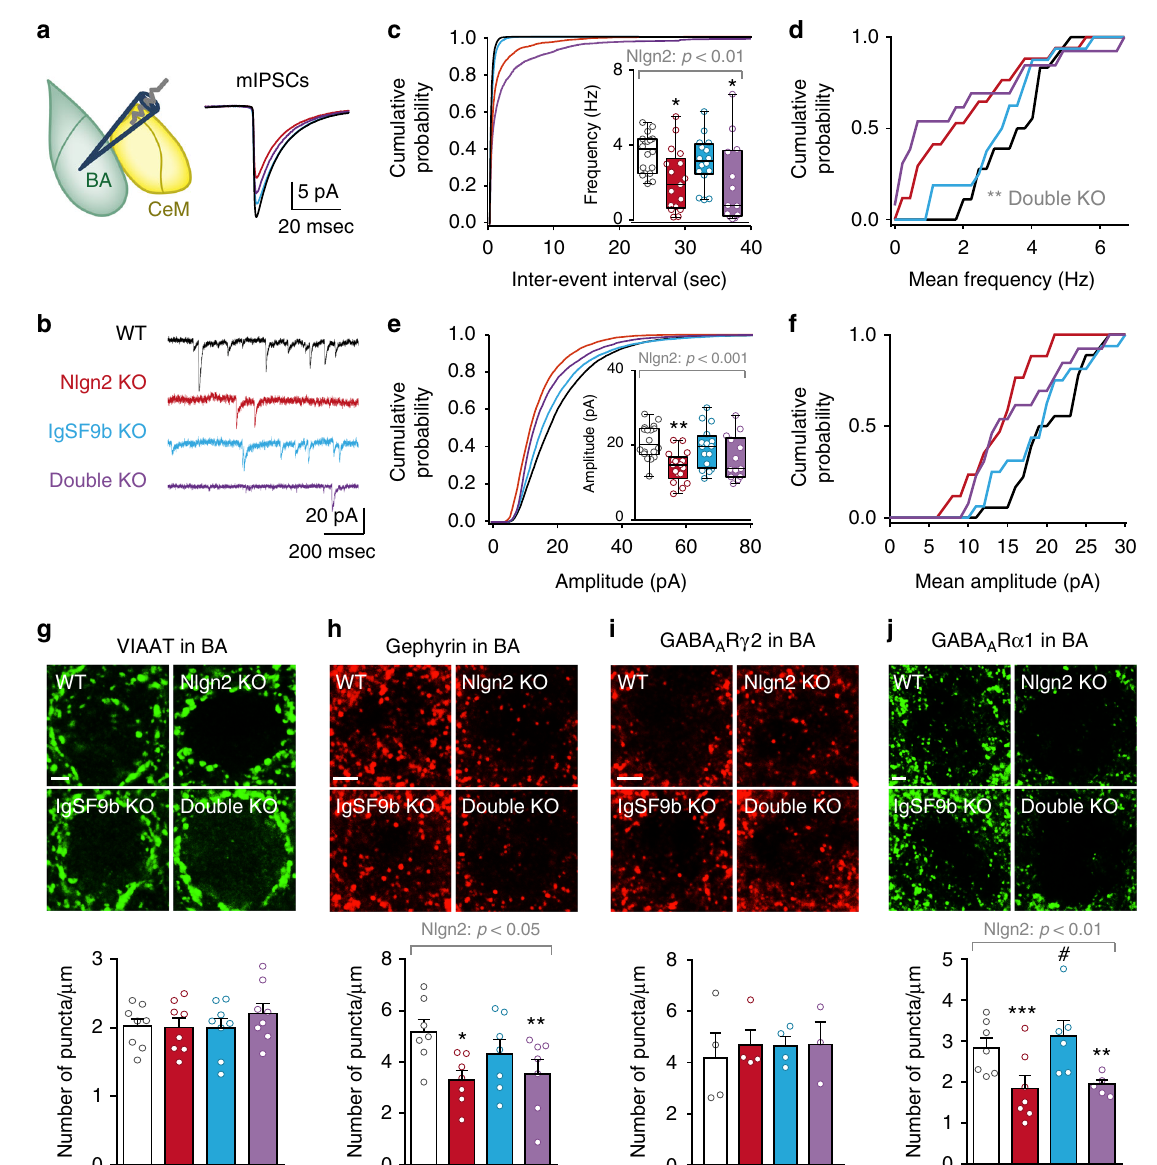
Fig. 7 IgSF9b deletion does not affect inhibitory synapses in the BA. a , b Schematic diagram illustrating recording sites in the BA, mean mIPSCs and representative mIPSC traces from the BA of WT, Nlgn2 KO, IgSF9b KO, and double KO mice. c Average cumulative distribution of mIPSC inter-event intervals and quanti fi cation of mean mIPSC frequency in the BA. d Probability distribution of mean mIPSC frequency of each analyzed cell in the BA. Kolmogorov – Smirnov test: WT vs. Double KO, p < 0.0001. e Average cumulative distribution of mIPSC amplitudes and quanti fi cation of mean mIPSC amplitude in the BA. f Probability distribution of mean mIPSC amplitude among all analyzed cells in the BA. n = 13 – 18 cells/5 – 6 mice per genotype. g – j Photomicrographs and quanti fi cation of the number of perisomatic puncta of g VIAAT, h gephyrin, i GABA A R γ 2, and j GABA A R α 1 in all four genotypes. Scale bar, 2 μ m. n = 3 – 8 per genotype. Statistically signi fi cant ANOVA comparisons are marked in gray at the top of the panels and are listed in Table 1. For all other ANOVA comparisons F < 1. Post-hoc analysis: * p < 0.05 relative to WT, ** p < 0.01 relative to WT, *** p < 0.001 relative to WT, # p < 0.05 relative to double KO. Error bars represent SEM. Box plots represent median and 25 th and 75 th percentiles and whiskers are drawn from the minimum to the maximum value. WT, white bars; Nlgn2 KO, red bars; IgSF9b KO, blue bars; double KO, purple